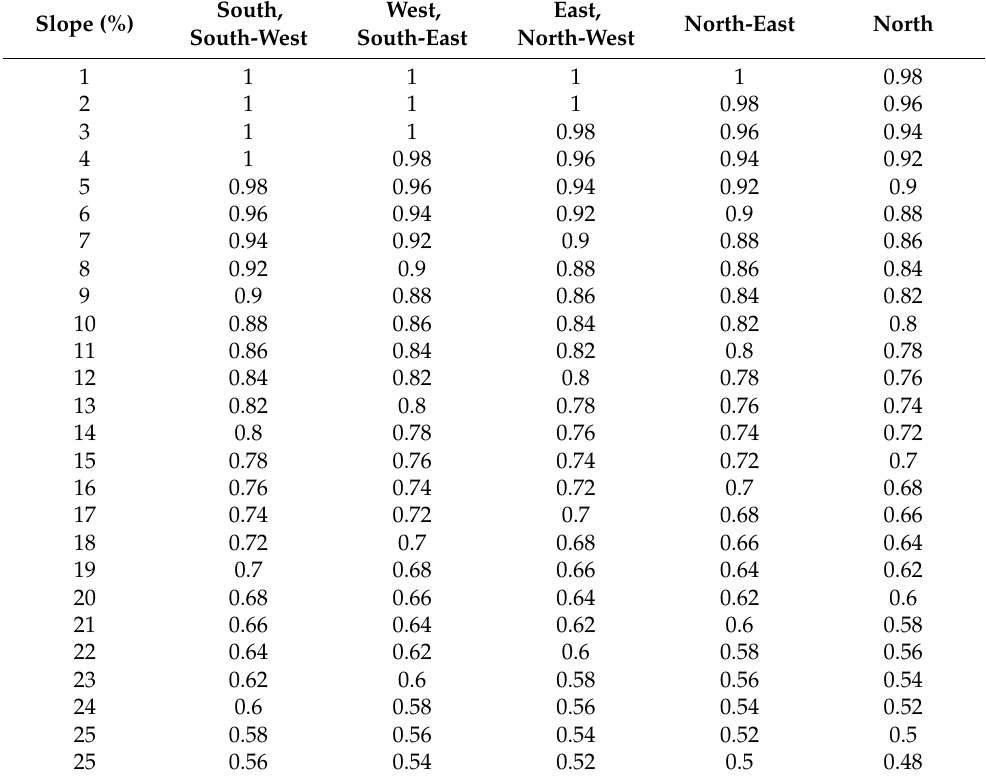
Table A1. Coefficients to modify the computed productivity based on slope relief and orientation [49]. Slope (%)